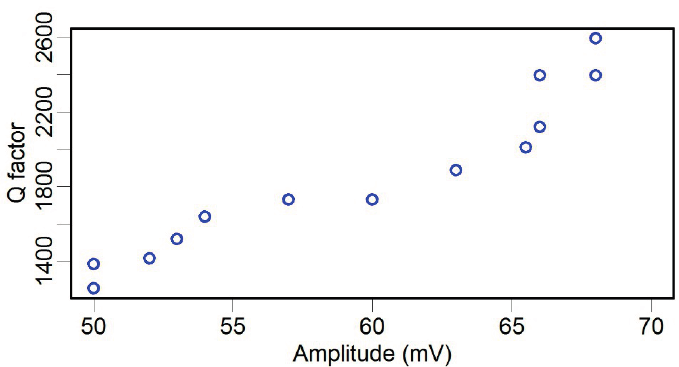
Figure 10. Q factor vs. atmospheric pressure of a TF-probe.